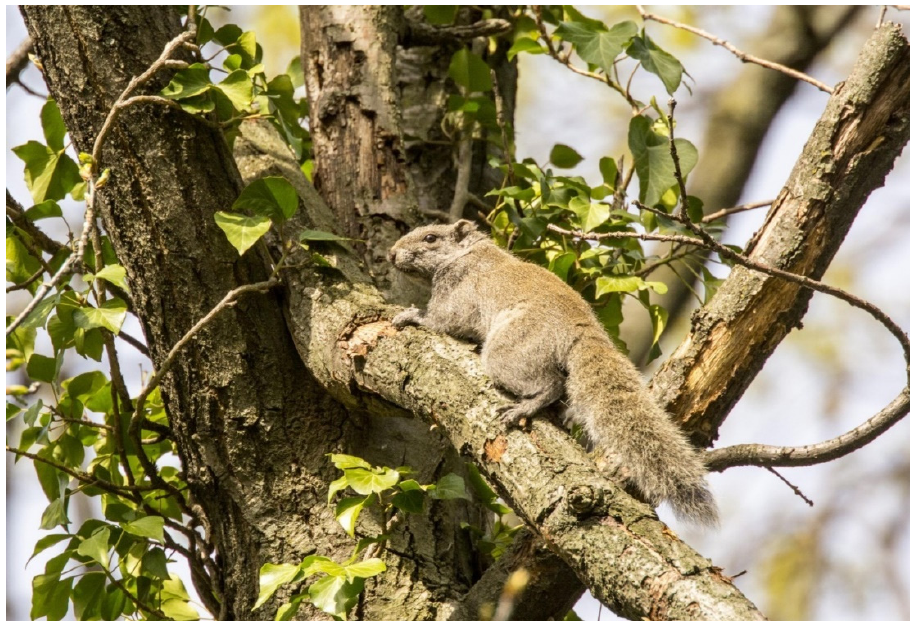
Figure 1. Pallas’s squirrel, Callosciurus erythraeus , in Laveno Mombello, Varese Province, Italy. Photo